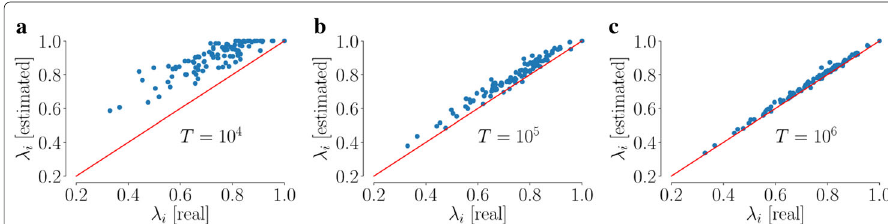
Fig. 7 Dependence of the identification performance on the duration of the time-window T . Estimation of the entries of the weights vector λ for increasing duration of the time-window T , with γ i = ¯ γ i , ∀ i ∈ V . For small values of T , setting γ i = ¯ γ i seems to yield an overestimation of the contribution of communities in the link generation mechanism